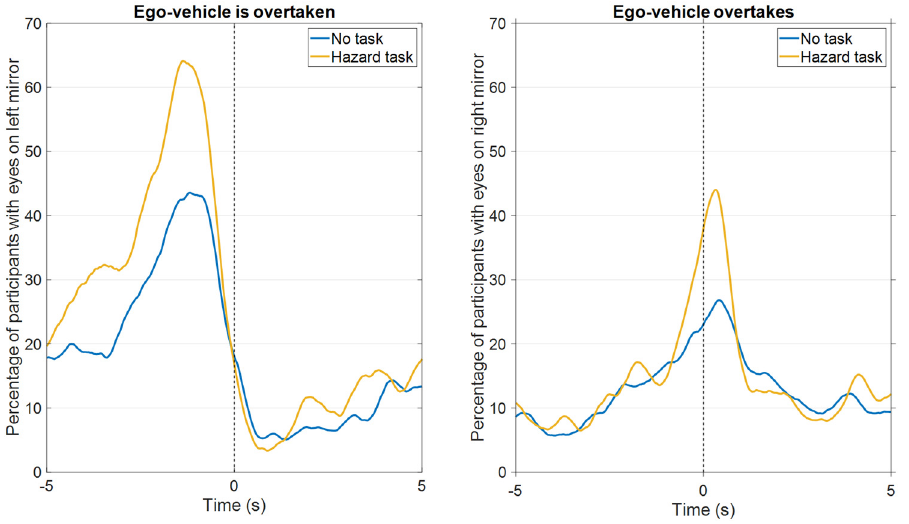
Figure 11. Percentage of participants with their eyes on the left mirror when another vehicle overtook the ego-vehicle in the left lane (left panel) and with their eyes on the right mirror when the ego-vehicle overtook another vehicle in the right lane (right panel) (Videos 1–3 combined, 8 and 15 overtakes, respectively). The vertical line at t = 0 s represents the first moment when part of the overtaking car became visible in the left side window ( left panel ) or the last moment when part of the overtaken car was visible in the front window ( right panel ).